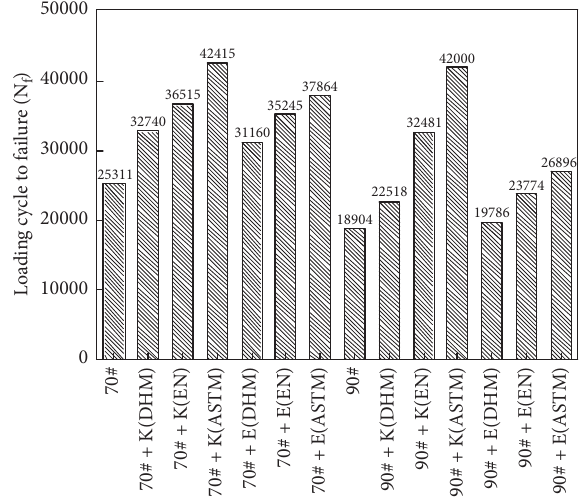
Figure 11: LAS test fatigue life of emulsified asphalt residues at the 2.5% strain